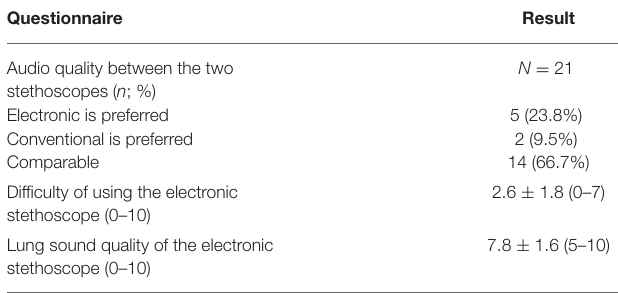
TABLE 4 | User satisfaction with the electronic